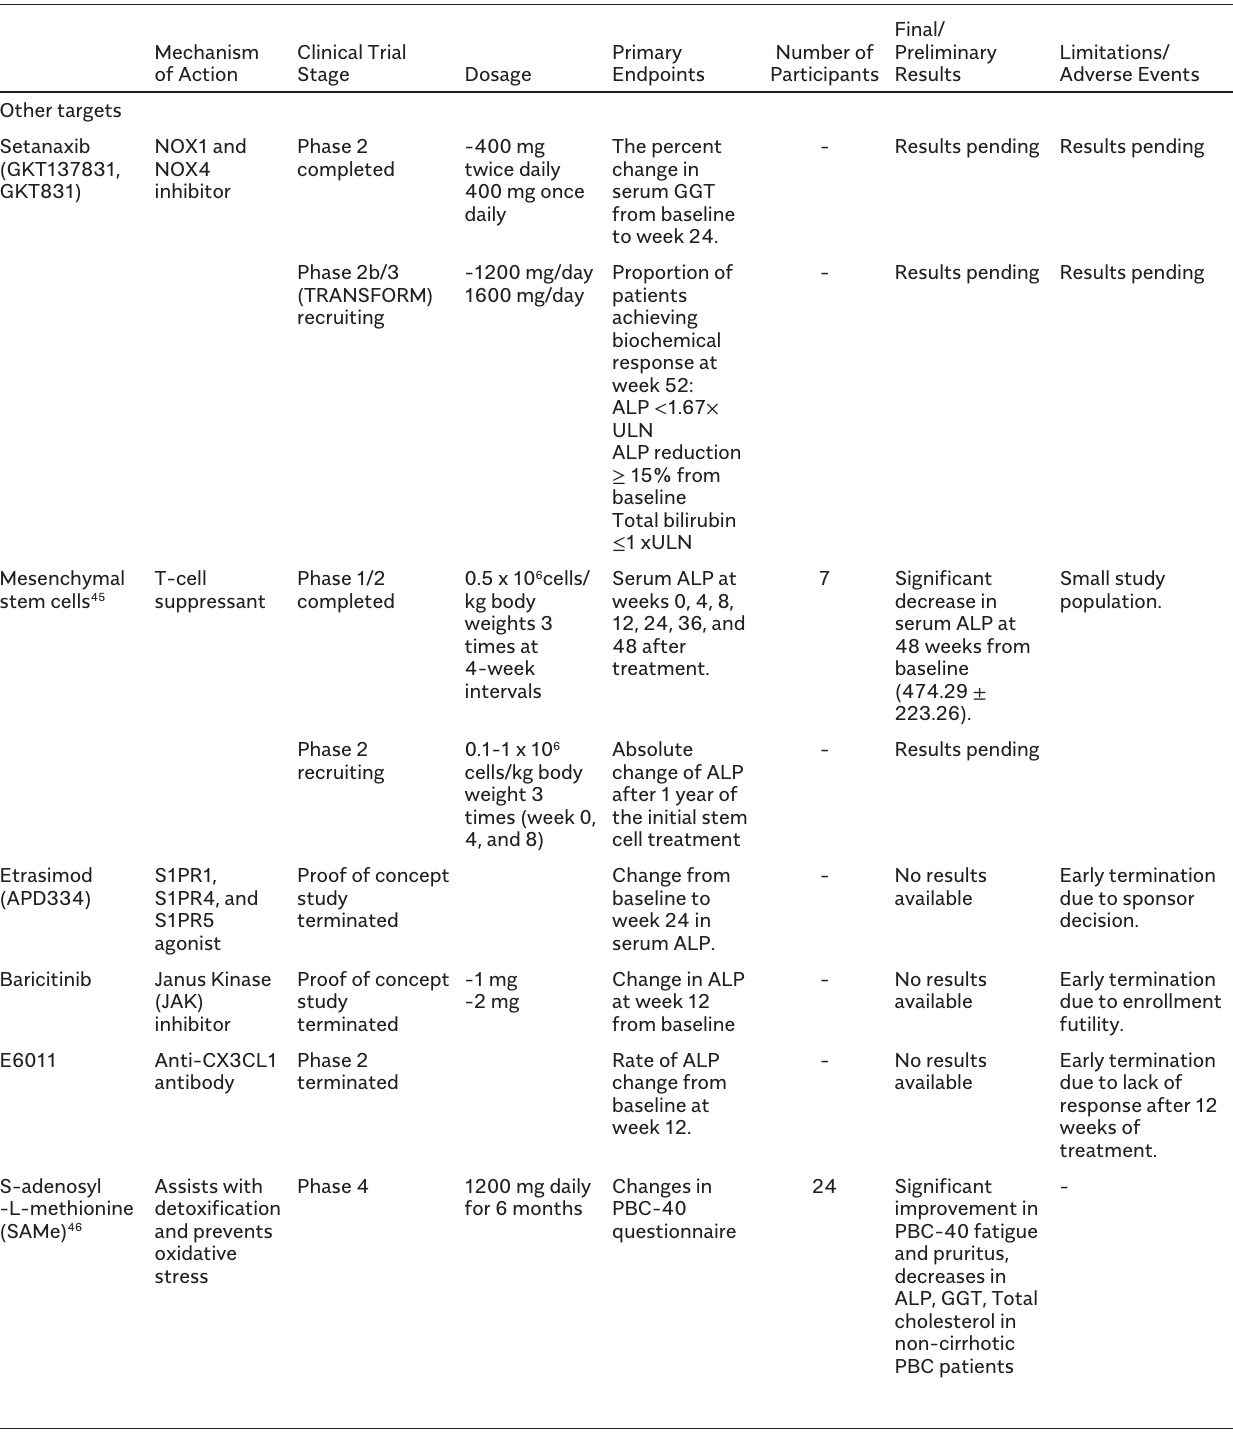
Table 2. Investigational Therapeutics for the Treatment of Primary Biliary Cholangitis